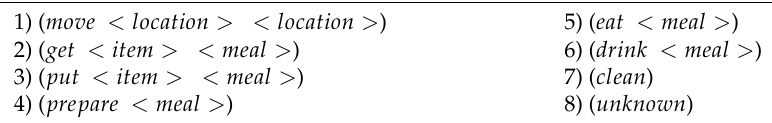
Table 3. The actions schema for the ontology.